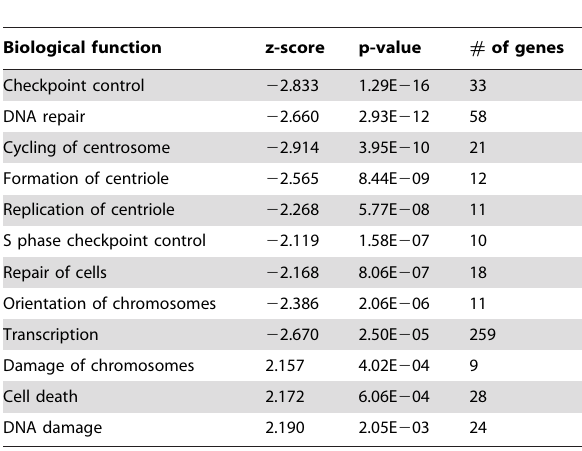
Biological processes are listed in order of statistical significance after applying a cutoff based on z-scores with an absolute value greater than 2. Negative z- scores indicate downregulation; positive z-scores indicate upregulation.